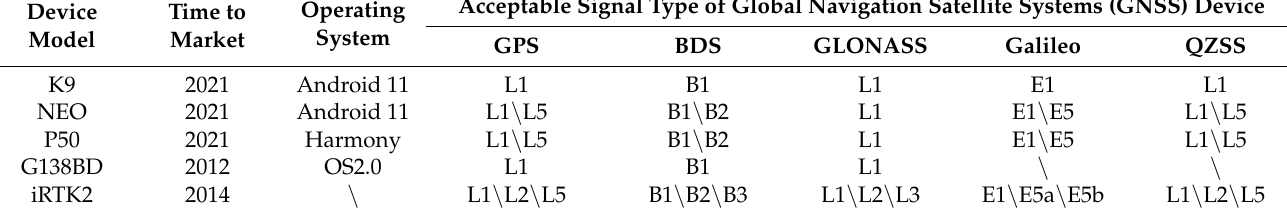
Table 1. Satellite systems are supported by every